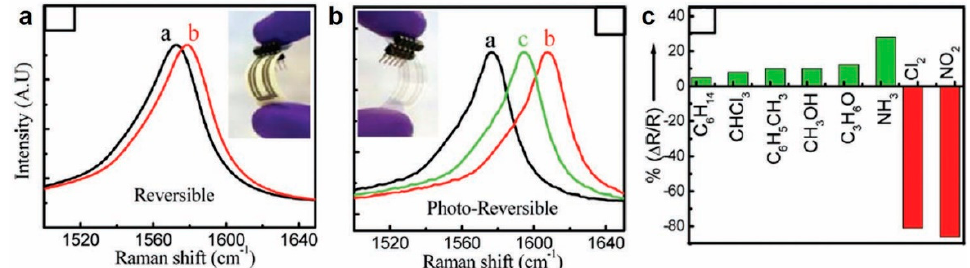
Figure 10. Raman shifts before (“ a ”, black) and after (“ b ”, red) exposure to 100 ppm Cl 2 vapor for ( a ) inkjet-printed CNT / PET, where the shift is partially reversible upon photoirradiation (to “ c ”,green); ( b ) inkjet-printed CNT / paper, where the shift is reversible. ( c ) Selectivity plot for an inkjet-printed CNT / PET film, sensor exposed to saturated organic vapors, NH 3 (100 ppm), NO 2 (100 ppm), and Cl 2 (100 ppm). Reproduced with permission from American Chemical Society [107].